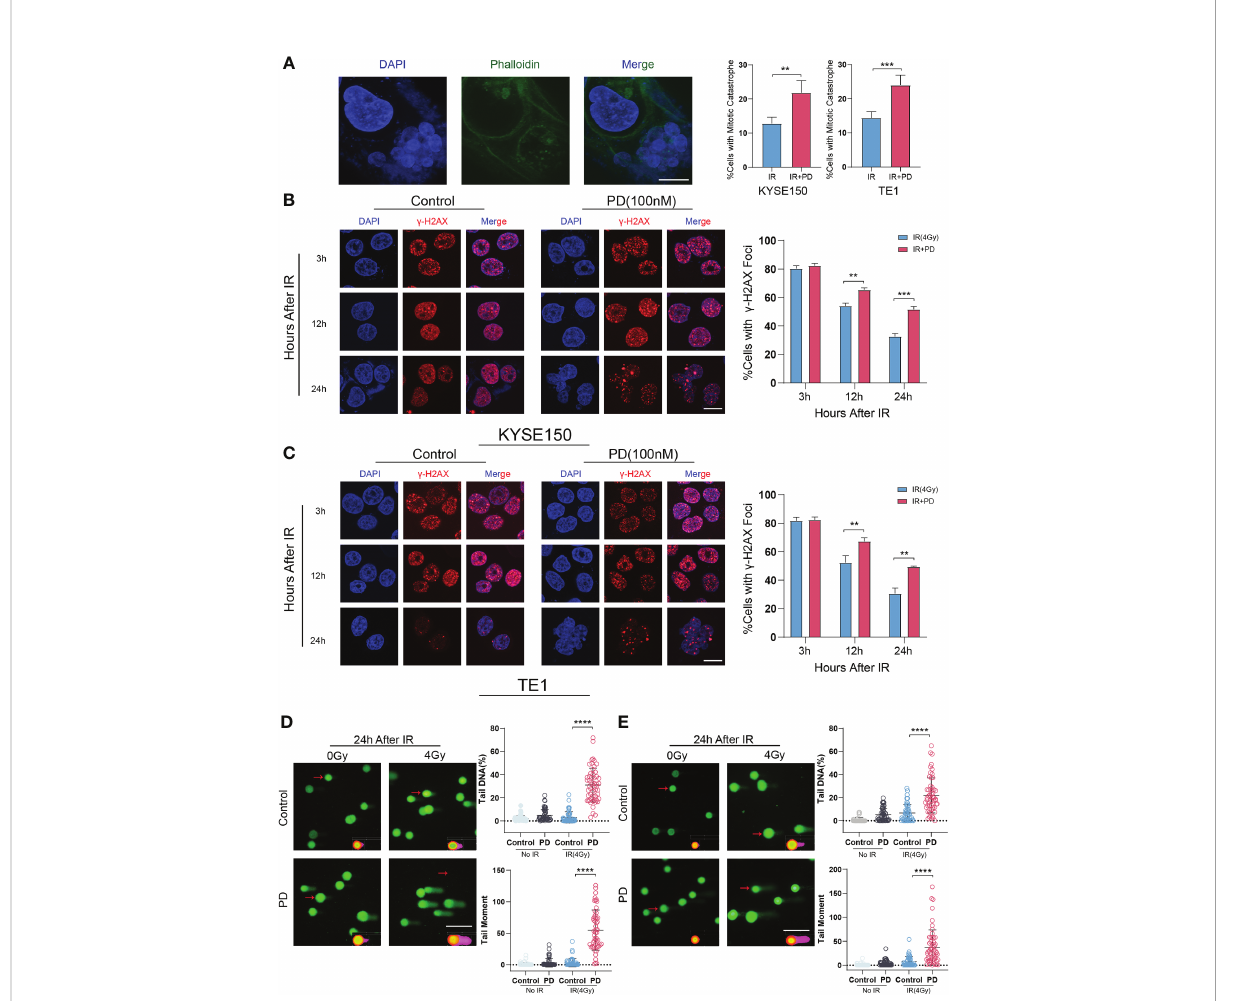
FIGURE 5 PD increases irradiation-induced DNA damage. (A) Irradiation induces mitotic catastrophe in ESCC cells, PD increases the proportion of mitotic catastrophe cells. (B, C) g -H2AX foci is measured in ESCC cells at different time points with irradiation, combination therapy has more foci per nucleus. Scale bar = 10 m m. (D, E) Alkaline comet assay of KYSE150 and TE1 cells is performed at 0 h, 6 h and 24 h after irradiation. Comet tails and tail moments are also quanti fi ed at the indicated time points. Scale bars: 2 m m (A) , 10 m m (B, C) , 20 m m. (D, E) **P < 0.01, ***P < 0.001, ****P <